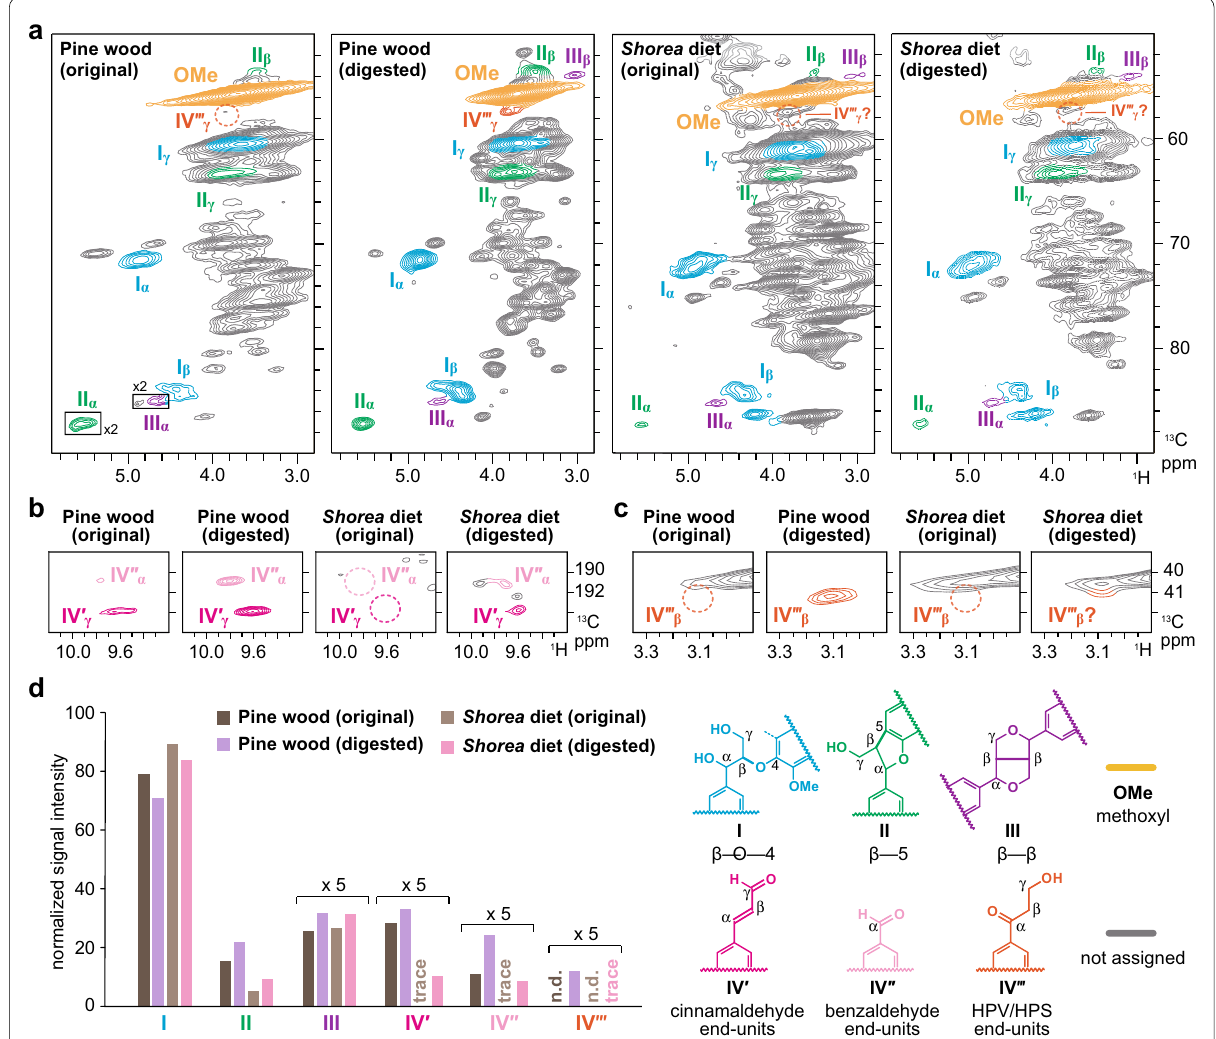
Fig. 4 Lignin inter-monomeric and end-unit linkage types in undigested and digested diets of N. hirtum. Oxygenated aliphatic ( a and c ) and aldehyde ( b ) sub-regions of 2D HSQC NMR spectra of pine wood and Shorea artificial diet lignocellulose samples before (“original”) and after (“digested”) digestion by N. hirtum larvae. Boxes labeled intensity values of the major lignin inter-monomeric linkage types ( I signals expressed as percentages of I purposes. Peak assignments are listed in Table